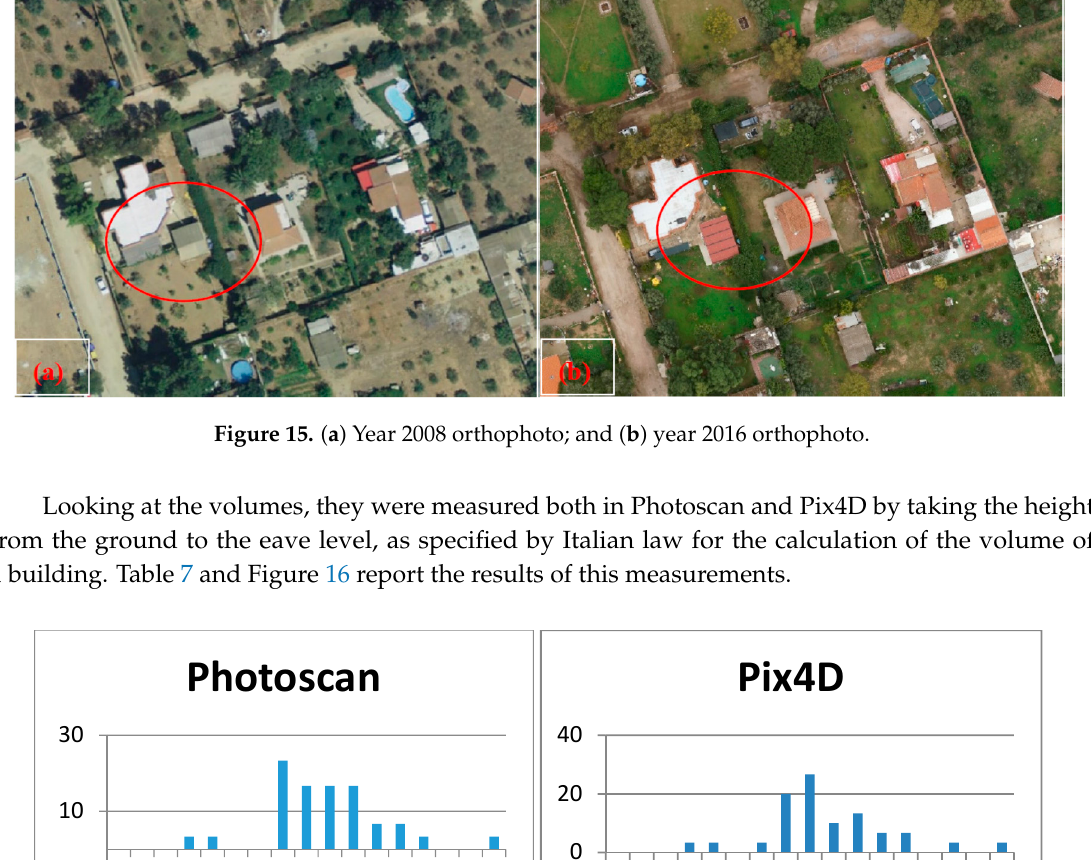
Figure 16. Volume data histograms with frequency (%) in the y-coordinate and differences in the x-coordinate.